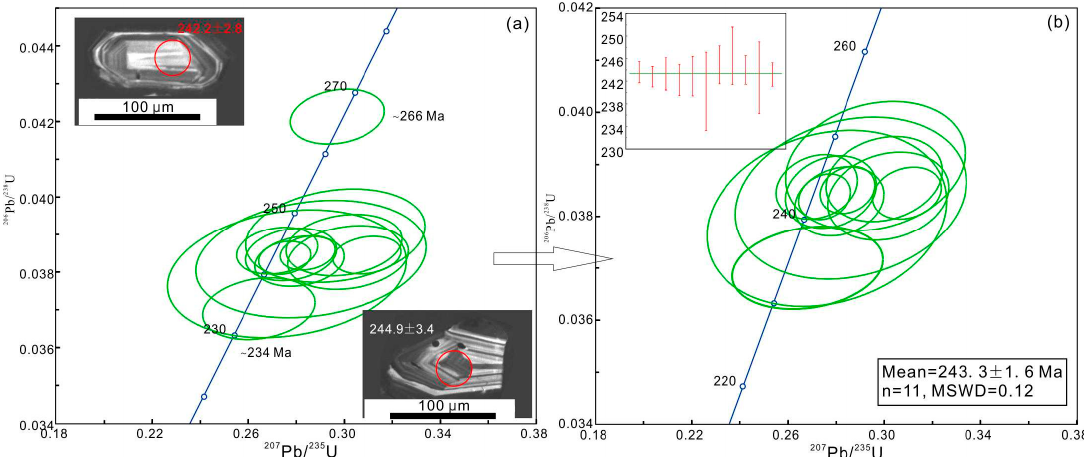
Figure 4. ( a ) Cathodoluminescence (CL) images and ( b ) concordia diagrams for zircons from the Kendenongshe rhyolitic tuff. Red circles represent the locations of LA–ICPMS U–Pb dating.